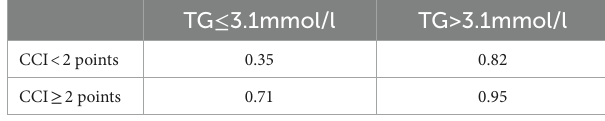
triglyceride. p < 0.05 was bolded. TABLE 6 Variables included in risk-score model and probability for recurrence of